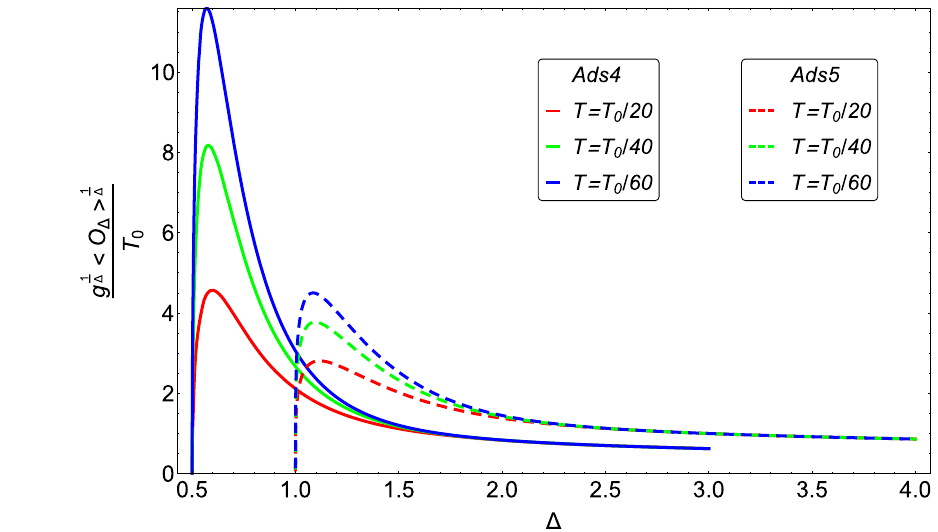
1 (cid:2) vs (cid:2) near T 0